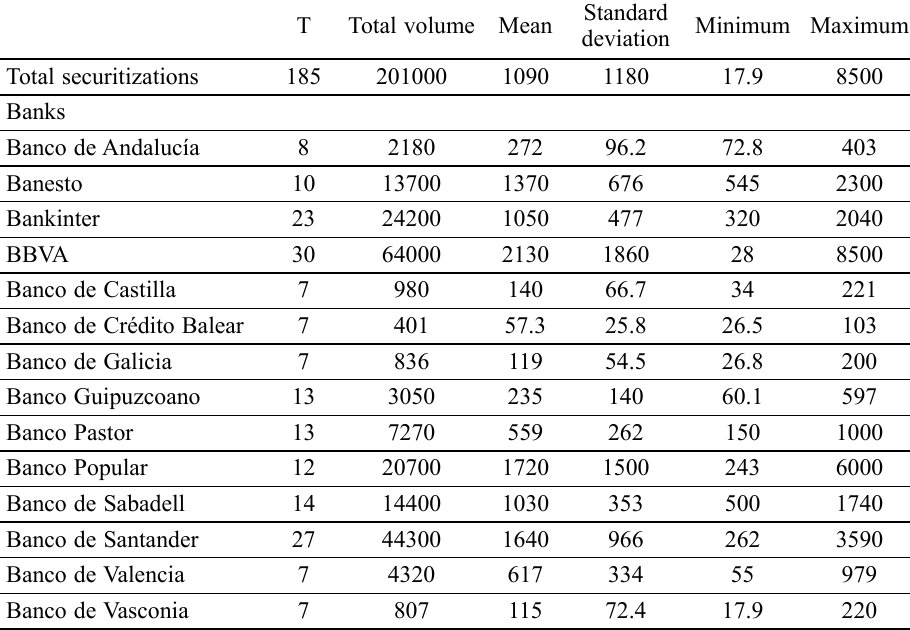
Table 1. Descriptive statistics. Issuing volume by bank in the sample (millions of €)